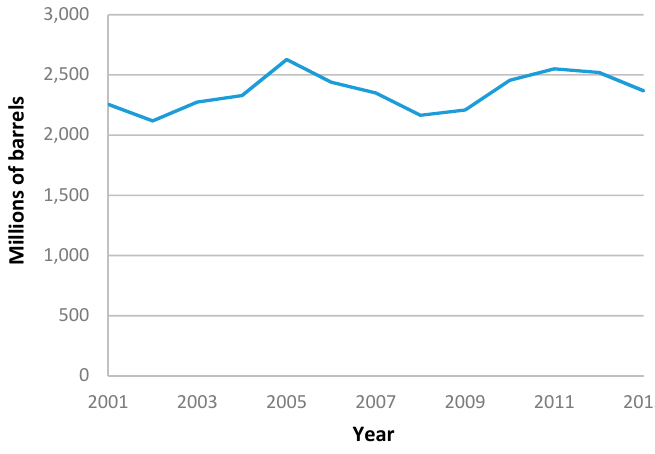
Figure 6. Crude oil production in Nigeria across 2001–2013 [32].